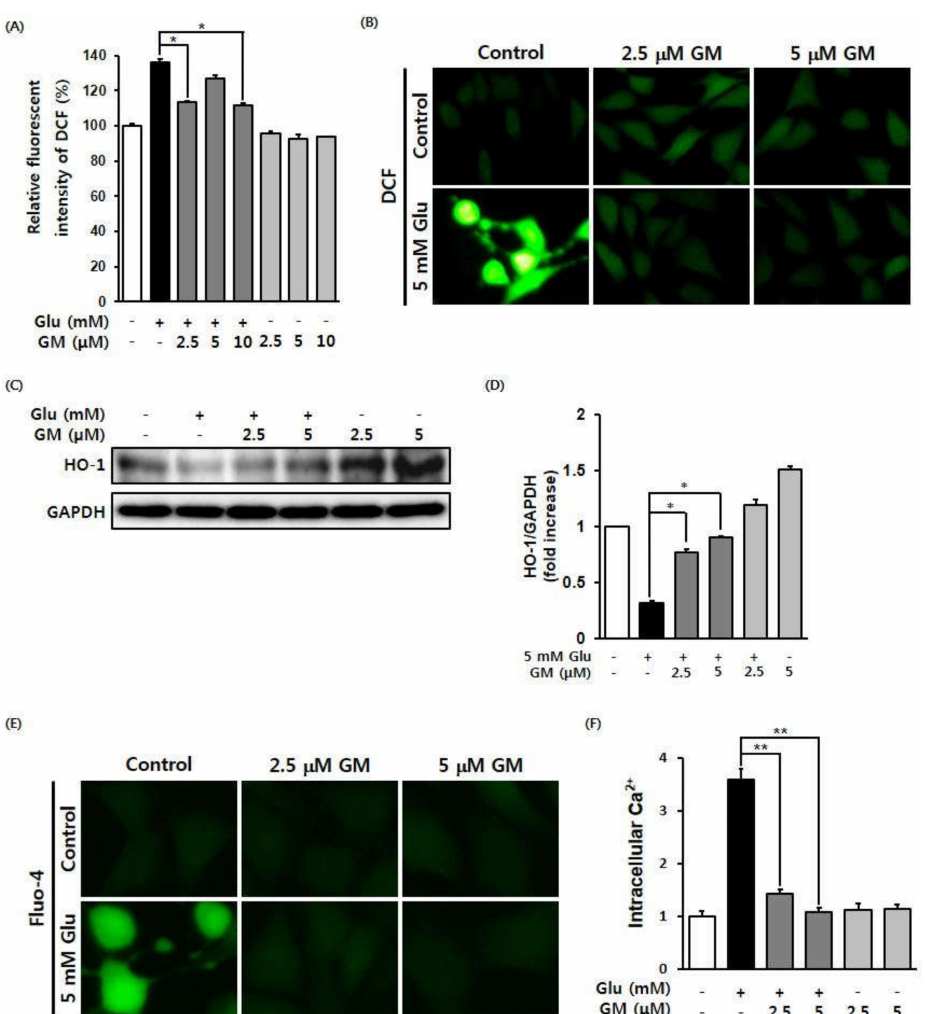
Figure 2. Effect of γ -mangostin (GM) on increased intracellular ROS and Ca 2+ levels following glutamate (Glu) treatment. ( A ) Inhibitory effect of GM against Glu-induced ROS accumulation in HT22 cells. Cells were treated with 5 mM Glu in the presence or absence of 2.5, 5, and 10 µ M GM for 8 h, and the fluorescence intensity of DCF (mean ± standard error of mean [SEM], * p < 0.05 compared to Glu-treated cells) was measured. ( B ) Cells were treated with 5 mM Glu along with 2.5 or 5 µ M GM for 8 h, and the fluorescence intensity was measured after staining the cells with DCFDA. The images were obtained with a fluorescence microscope (20x magnification). ( C ) Effects of GM on HO-1 protein expression in HT22 cells. Cells were treated with 5 mM Glu along with 2.5 or 5 µ M GM for 6 h, and a western blot analysis was performed using HO-1 and GAPDH antibodies. ( D ) Bars denote the fold-increases of HO-1 expression (mean ± SEM. * p < 0.05 compared to Glu-treated cells). ( E ) Inhibitory effect of GM on Glu-induced Ca 2+ accumulation in HT22 cells. Cells were treated with 5 mM Glu along with 2.5 or 5 µ M GM for 8 h and were stained with Fluo-4 AM. The images of cells were obtained using a fluorescence microscope (20 × magnification). ( F ) The fluorescence intensity was measured after staining the cells with Fluo-4 AM (mean ± SEM., ** p < 0.01 compared to Glu-treated